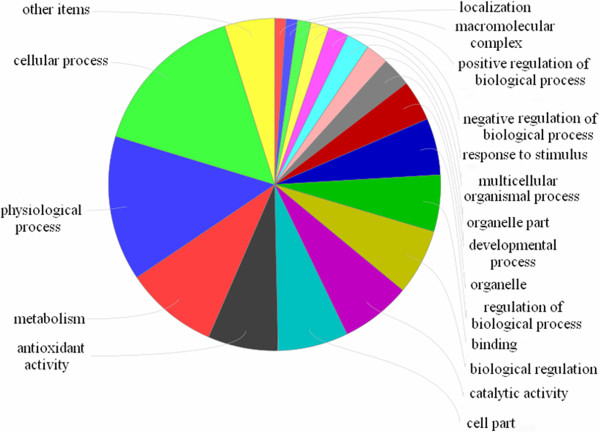
Ontology of differentially expressed proteins.